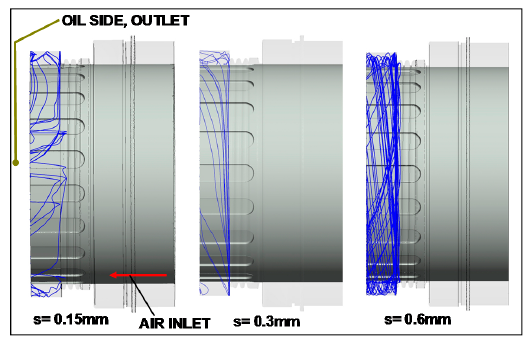
Figure 17. Oil particles trajectories at 15,000 rpm, three different pressure ratios and s = 0.3 mm.